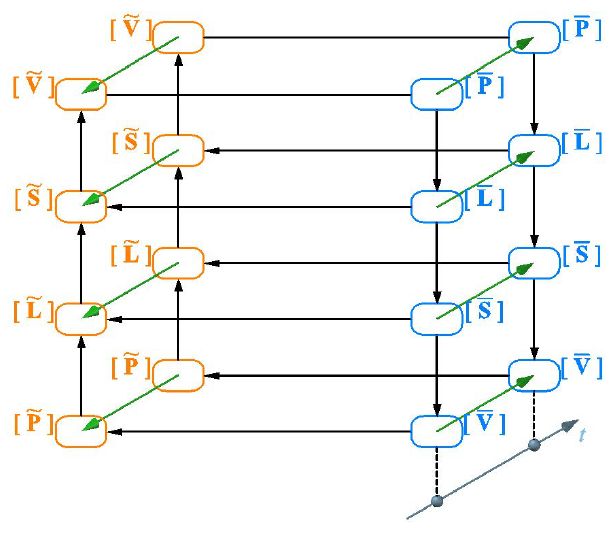
Figure 5: Space–time classification diagram of the physical vari- ables.